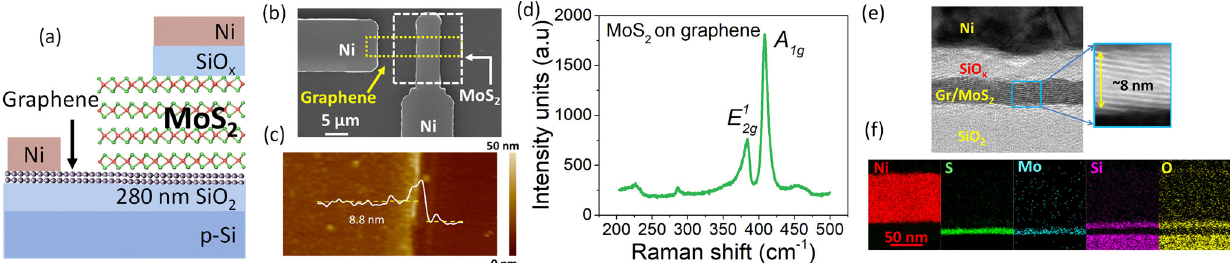
Fig. 1 Graphene / MoS 2 /SiO x /Ni memristive device schematic. a Device schematic of graphene / MoS 2 /SiO x synapse. b SEM image of the graphene / MoS